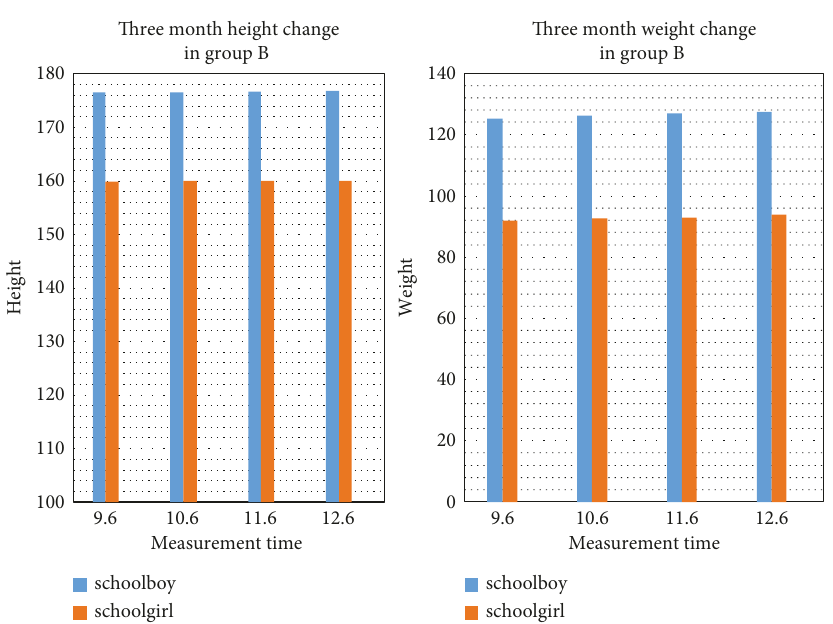
Figure 5: Height and weight of male and female students in group